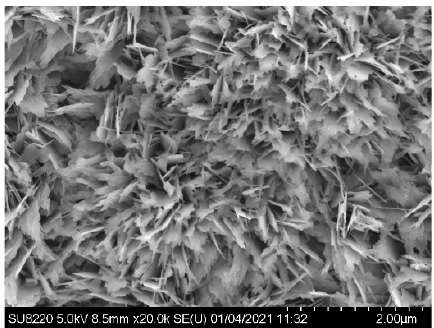
Figure 3. Schematic diagram of the open microchannel flow passage.